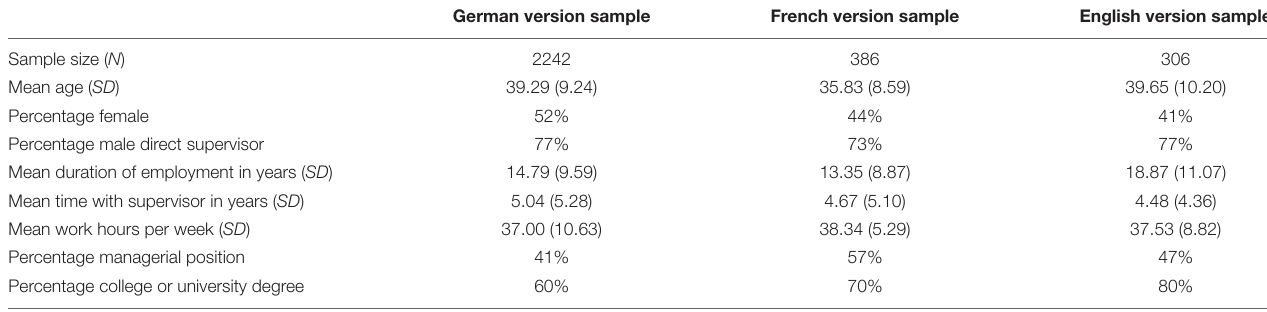
TABLE 2 | Characteristics of the three